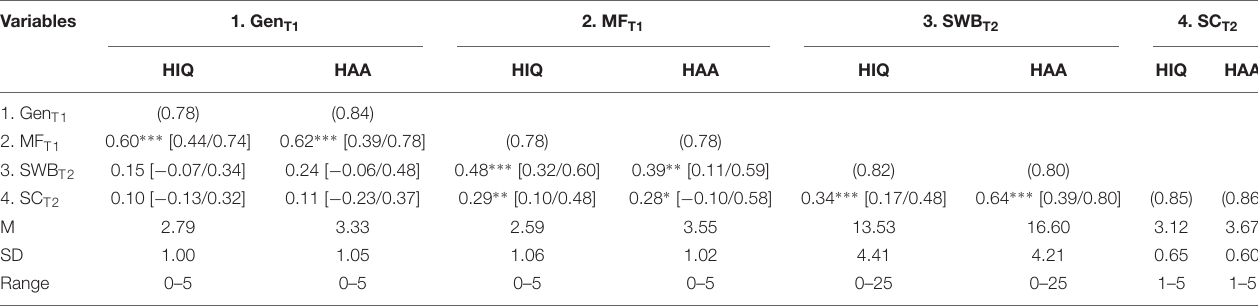
FIGURE 2 | Statistical diagram of the moderated mediation model with subjective well-being as dependent variable ( Y ), generativity as independent variable ( X ), meaningfulness as mediator ( M ), and self-control as moderator ( W ) while controlling for family status (C1), age (C2), and gender (C3). TABLE 1 | Partial correlations, descriptives, and reliabilities of generativity, meaningfulness, subjective well-being, and self-control among (a) intellectually gifted and (b) high academic